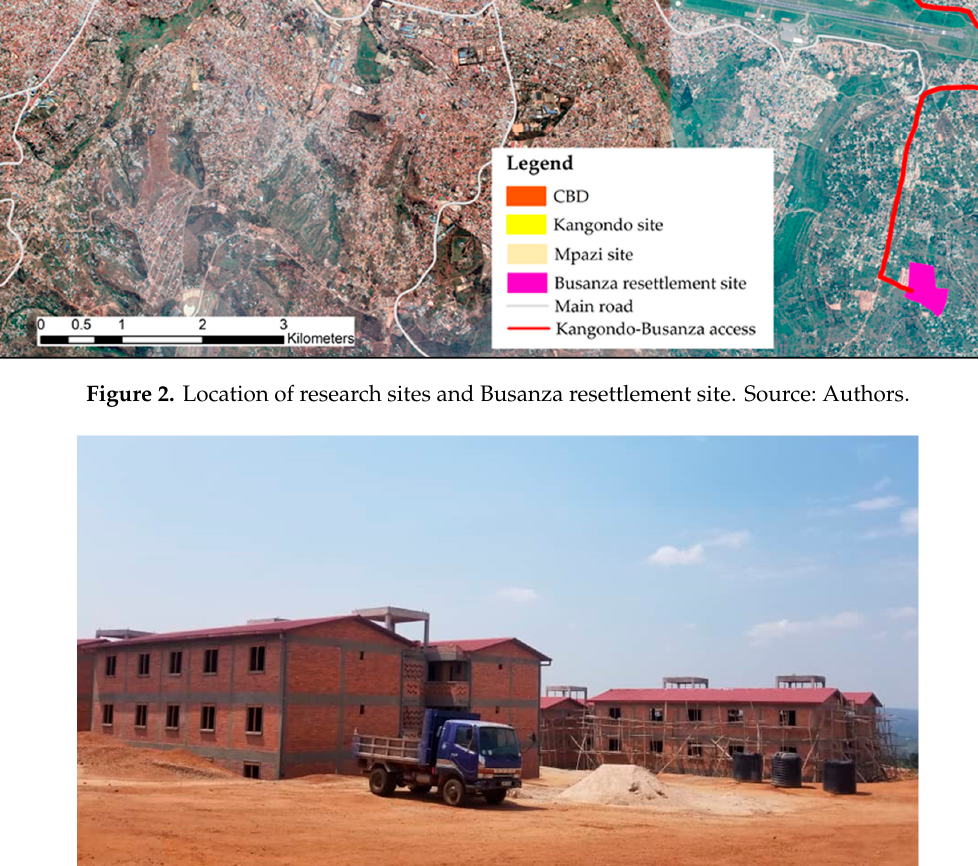
Figure 3. Construction of apartments for Kangondo residents at the Busanza resettlement site. Source: 286 This picture was taken by Ernest Uwayezu in September 2019. 287